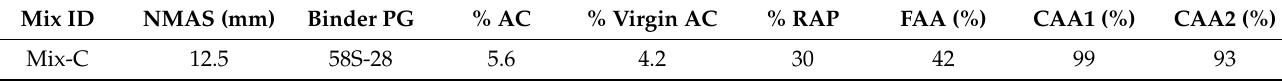
Table 1. Material information of the